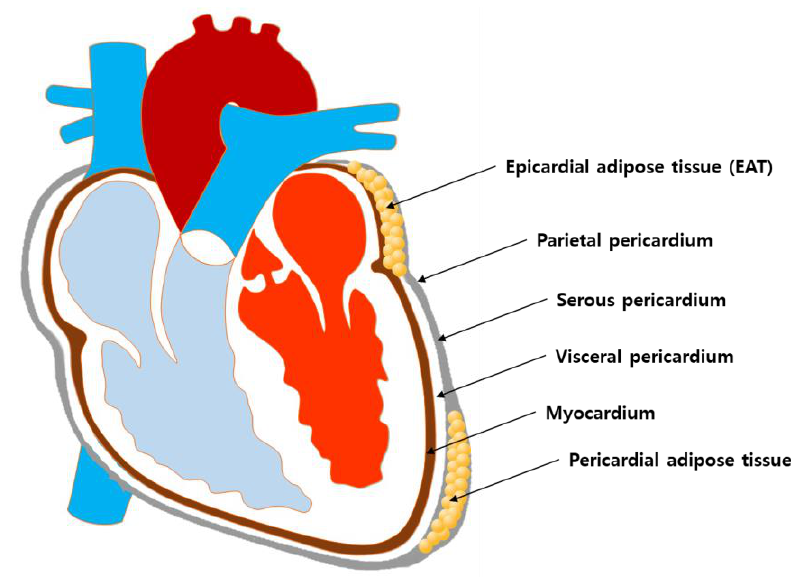
Figure 1. Schematics of the anatomical location of EAT and PAT in the heart.